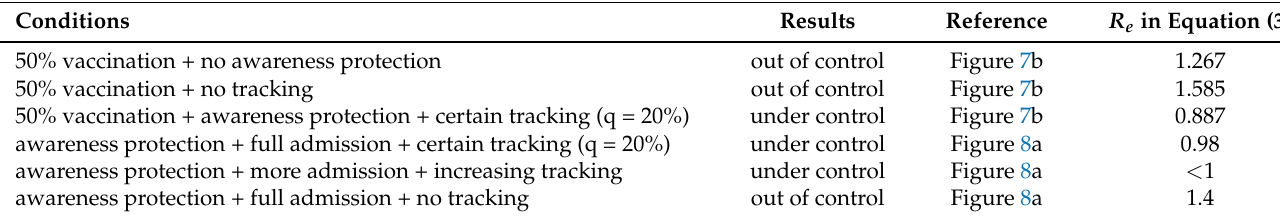
Table 3. Conditions and control